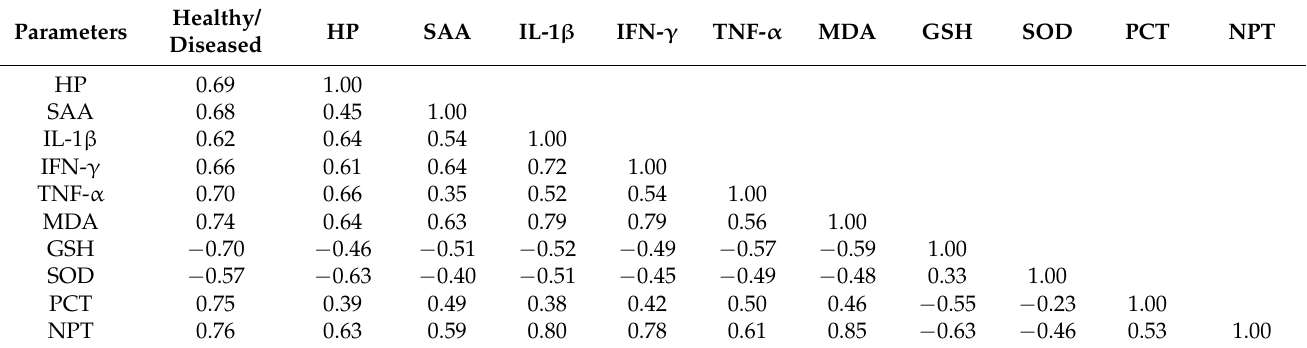
Table 1. Correlation matrix among acute-phase proteins (HP, Haptoglobin; SAA, serum amyloid A), proinflammatory cytokines (IL1- β , Interleukin one beta; IFN- γ , Interferon gamma; TNF- α , tumor necrosis factor alpha), oxidative stress markers (MDA, malondialdehyde; GSH, reduced glutathione; SOD, super oxide dismutase), procalcitonin (PCT), and neopterin (NPT) in the serum of diarrheic feedlot calves naturally infected with C. parvum and healthy calves.